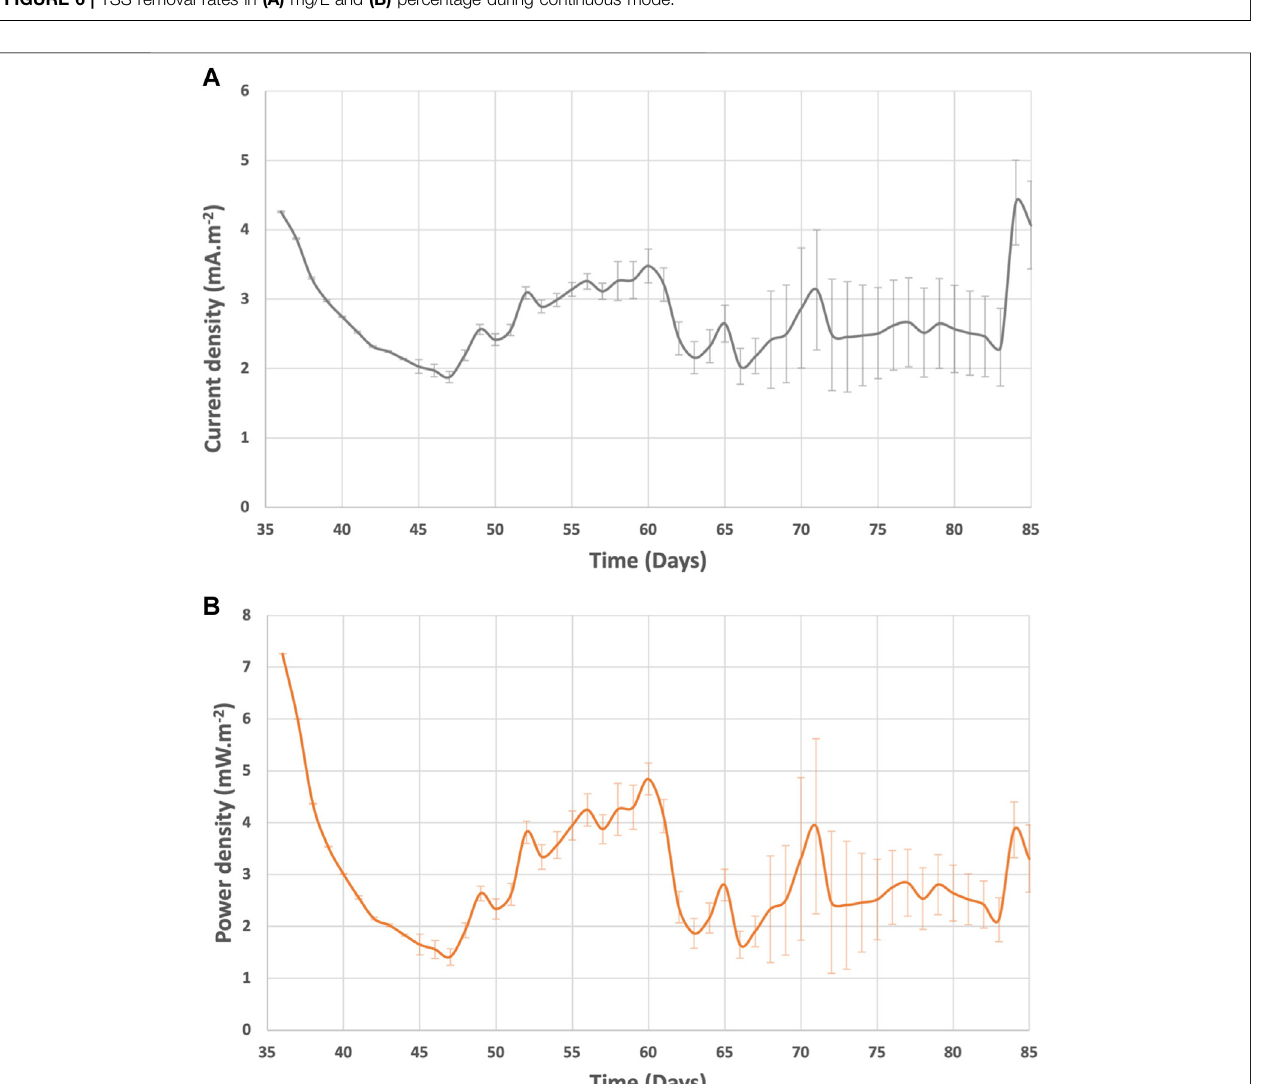
FIGURE 7 | (A) current density and (B) power density recorded during continuous mode.